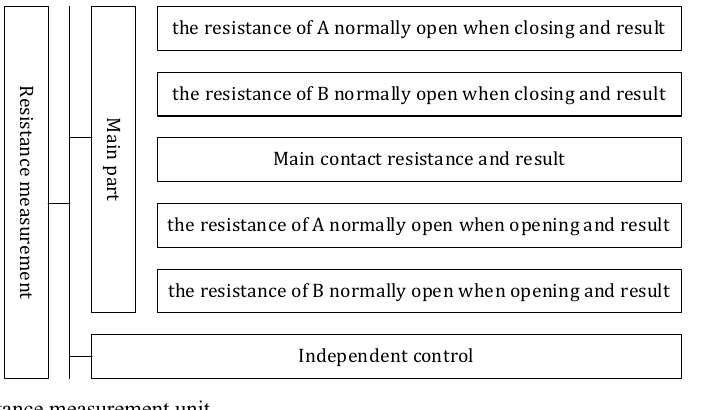
Fig. 3. Resistance measurement unit. Test status control and other functional information